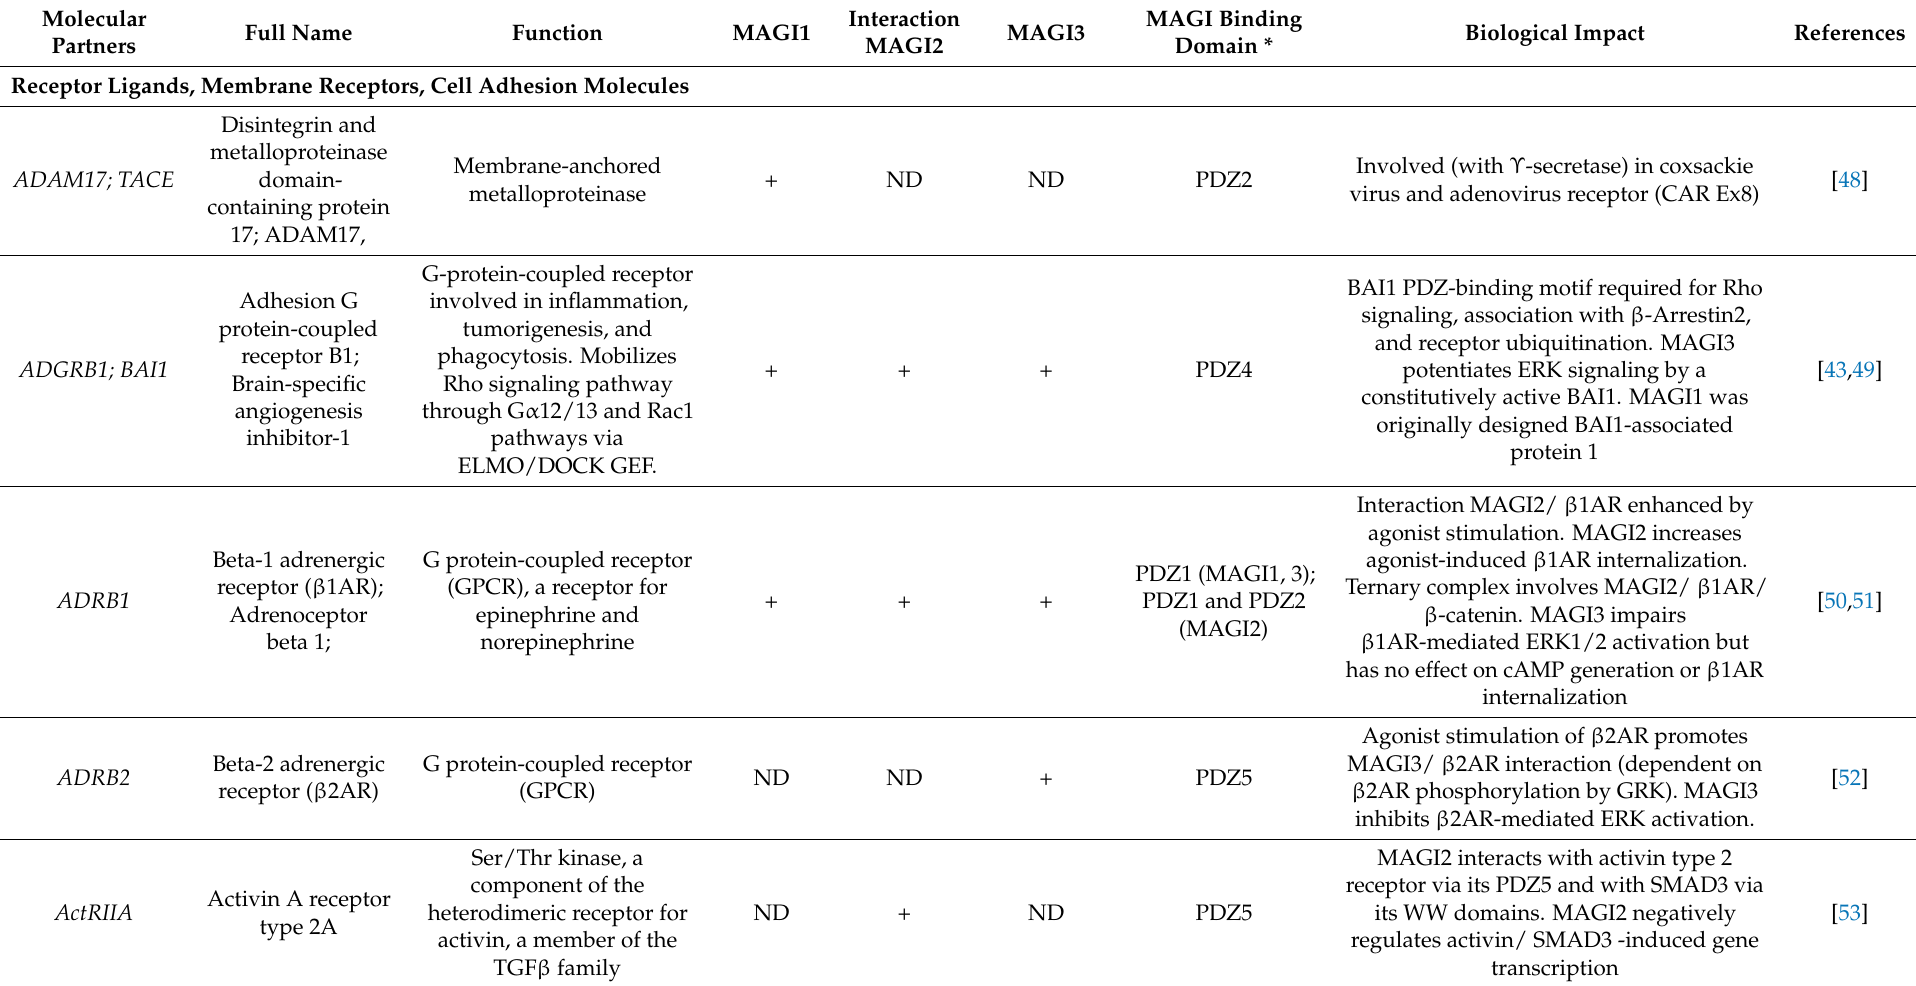
Table 1. A partial list of MAGI-interacting partners, domains involved, and functional